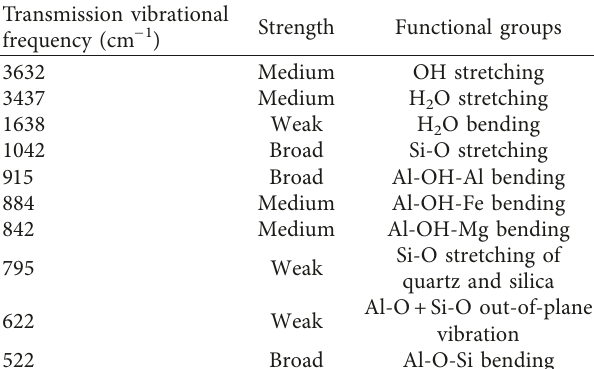
Table 2: IR bands characteristic of the purified bentonite spectrum. Transmission vibrational frequency (cm − 1